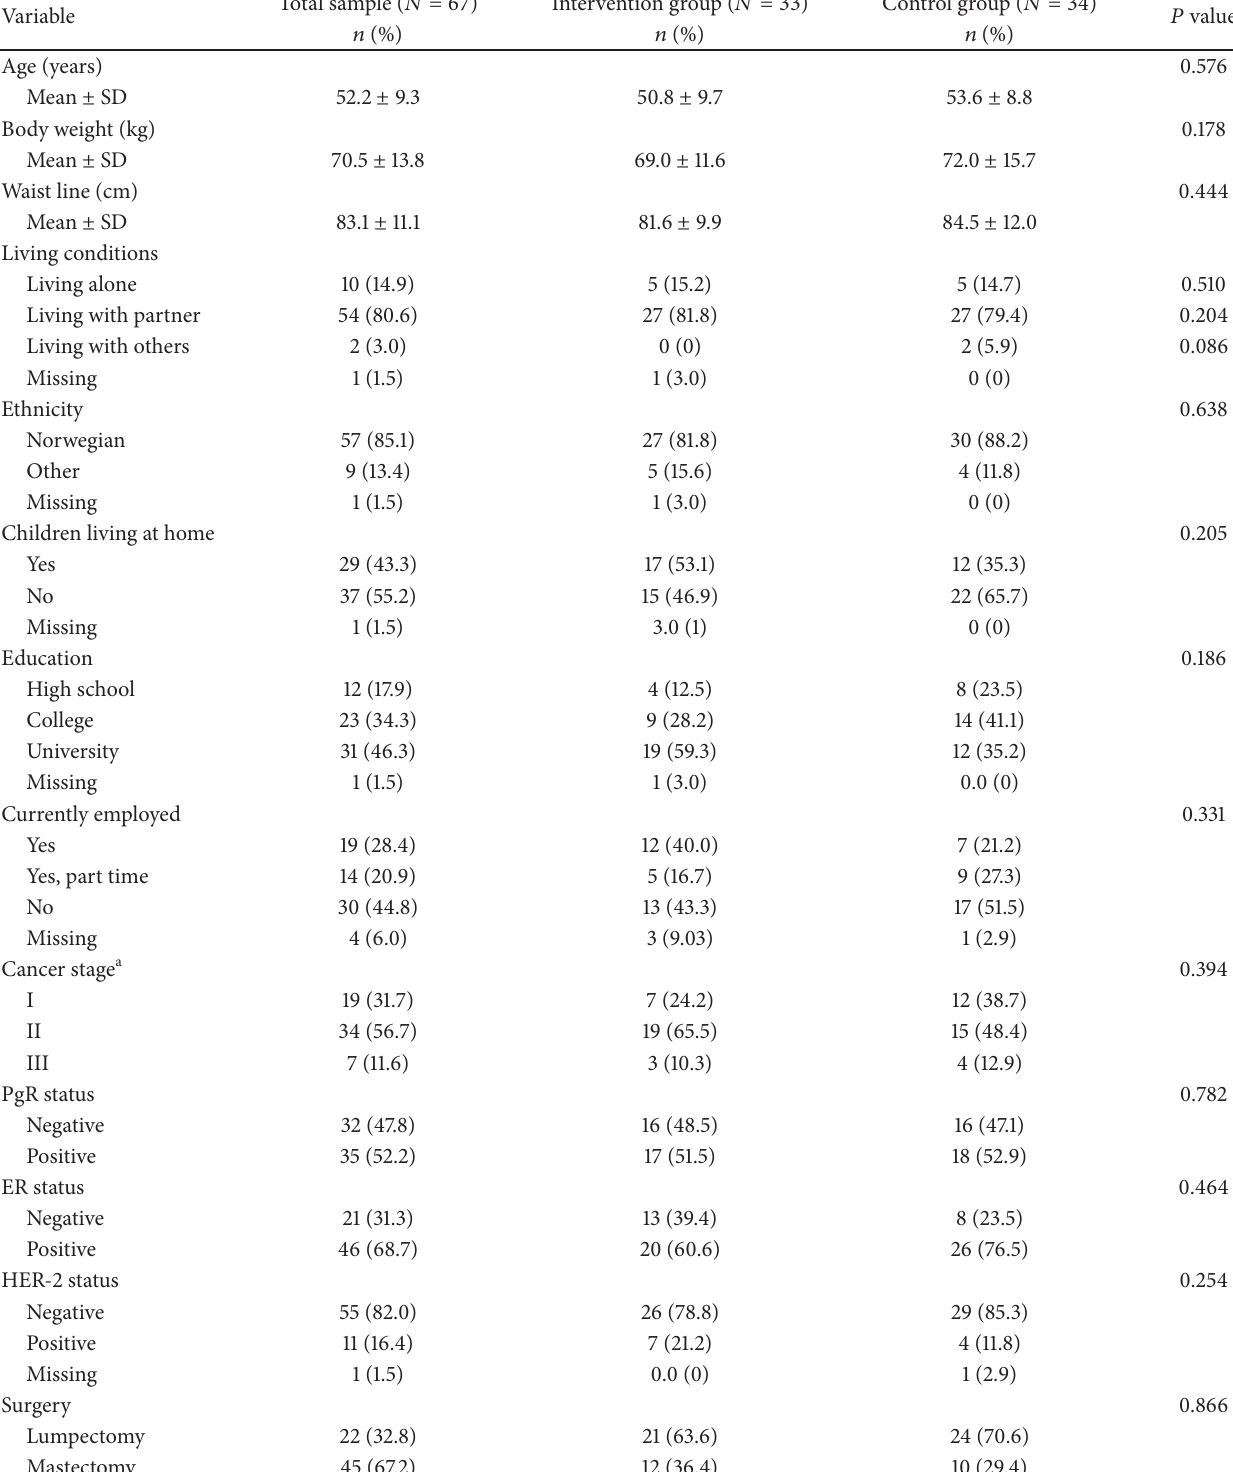
Table 1: Demographics and characteristics of study population ( 𝑁 = 67